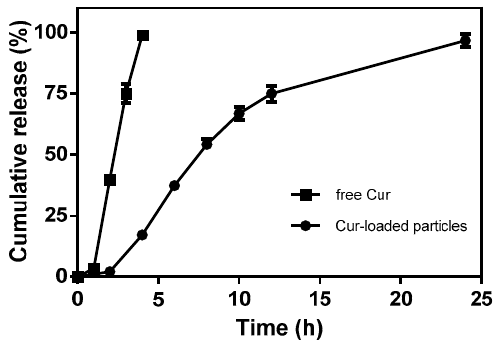
Figure 6. In-vitro release profiles of free Cur and encapsulated Cur from zein-caseinate-pectin Figure 6. In ‐ vitro release profiles of free Cur and encapsulated Cur from zein ‐ caseinate ‐ pectin particles.